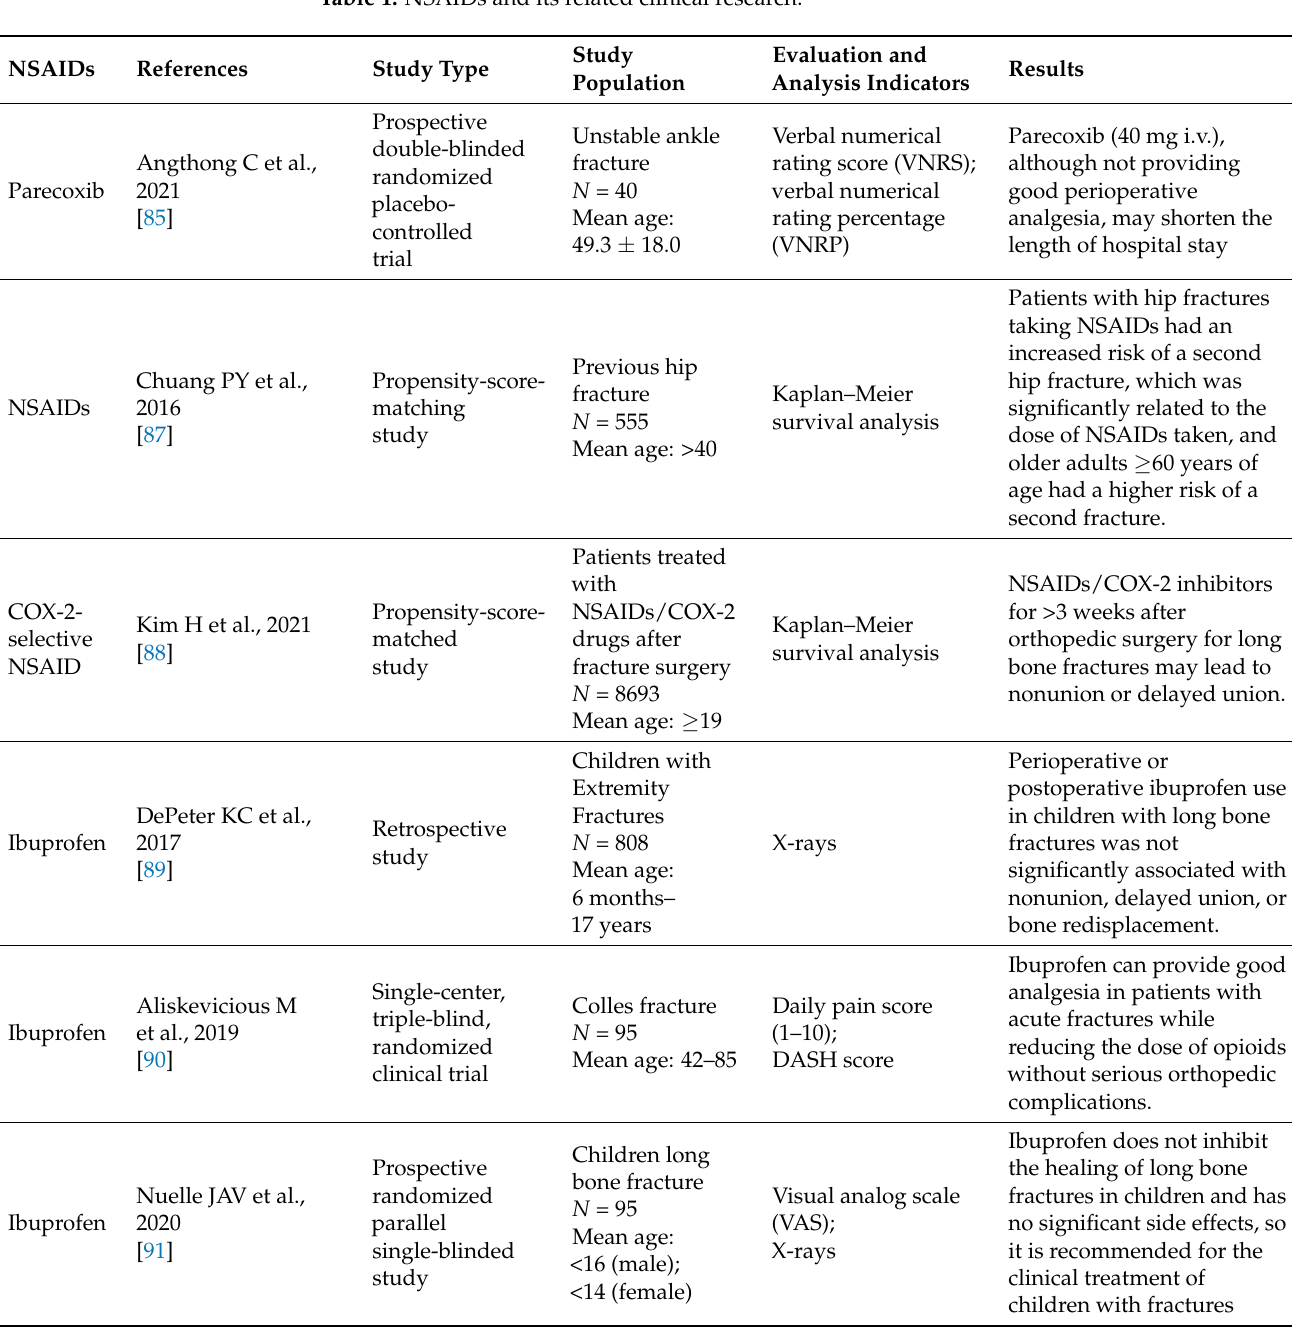
Table 1. NSAIDs and its related clinical